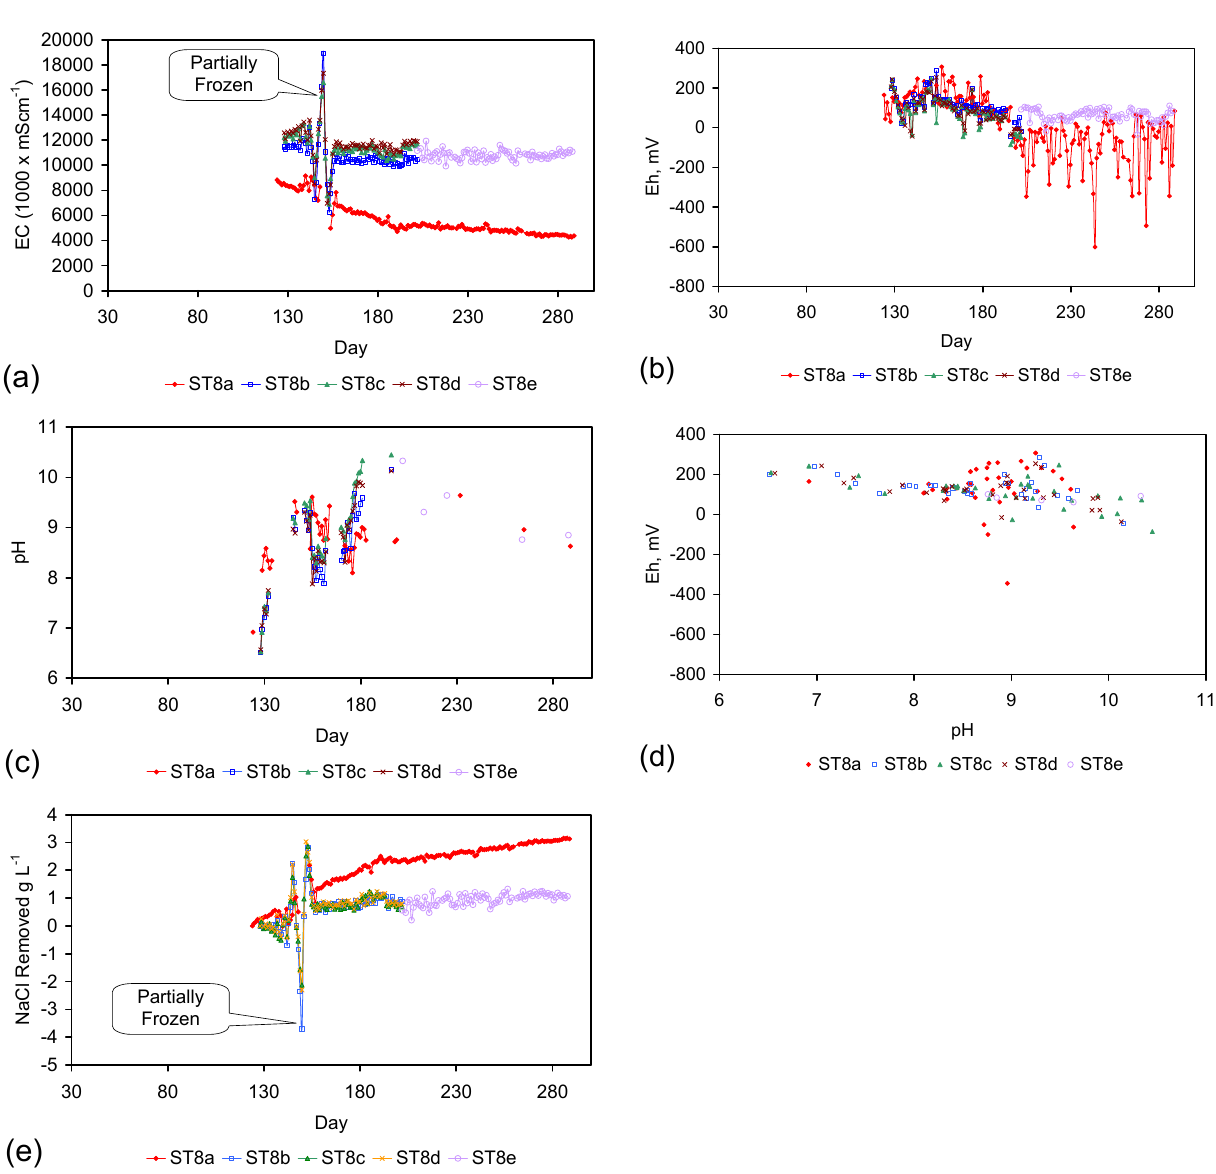
Figure C12. ( a ) EC vs. day; ( b ) Eh vs. day; ( c ) pH vs. day; ( d ) pH vs. Eh; ( e ) NaCl Removed (calculated from EC and residual water volume) vs. day. ST8a = 37 g·L − 1 ; ST8b = 43 g·L − 1 ; ST8c = 40.4 g·L − 1 ; ST8d = 26 g·L − 1 ; ST8e = 36.5 g·L − 1 . Reactor Size (ST8a): 0.3 L; Feed Water volume: 0.2 L. Reactor Size (ST8b–ST8d): 2.3 L; Feed Water volume: 2.3 L. Reactor Size (ST8e): 10 L; Feed Water volume: 6.9